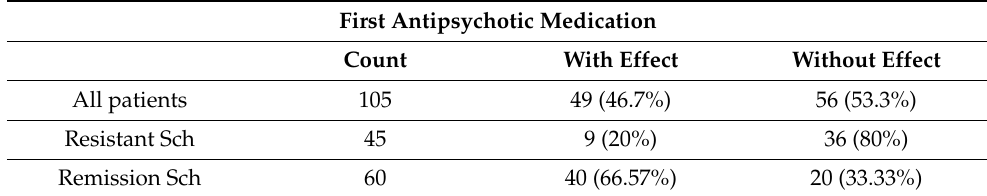
Table 1. Distribution of patients according to the effect of treatment. Sch = schizophrenia.